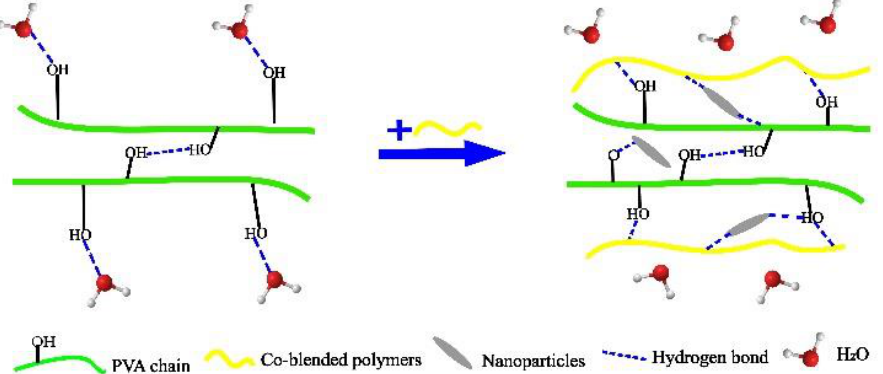
Figure 7. Diagram of the nanofiller and polymer co-blend acting together.